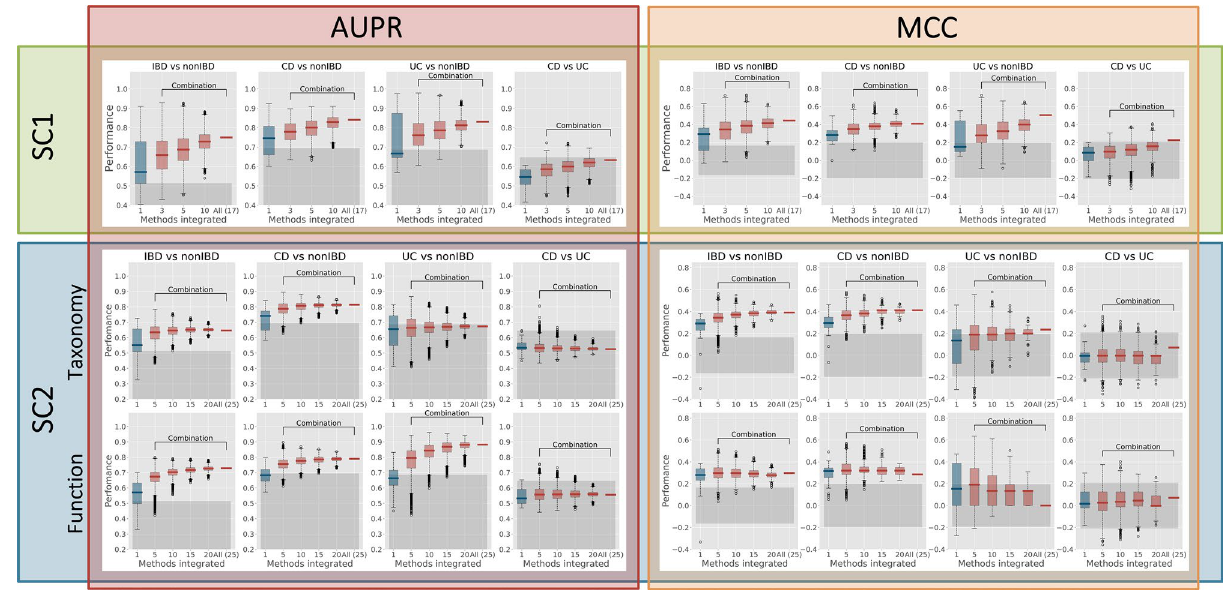
Figure 8. Comparison of the performance of assembly-based versus individual predictions. Results for different SCs, data types, 2-class tasks, and metrics are shown separately. The first boxplot depicts the performance distribution of individual methods. Further boxplots represent the performance when integrating > 1 randomly sampled methods. The last boxplot demonstrates one value obtained after integrating all the individual